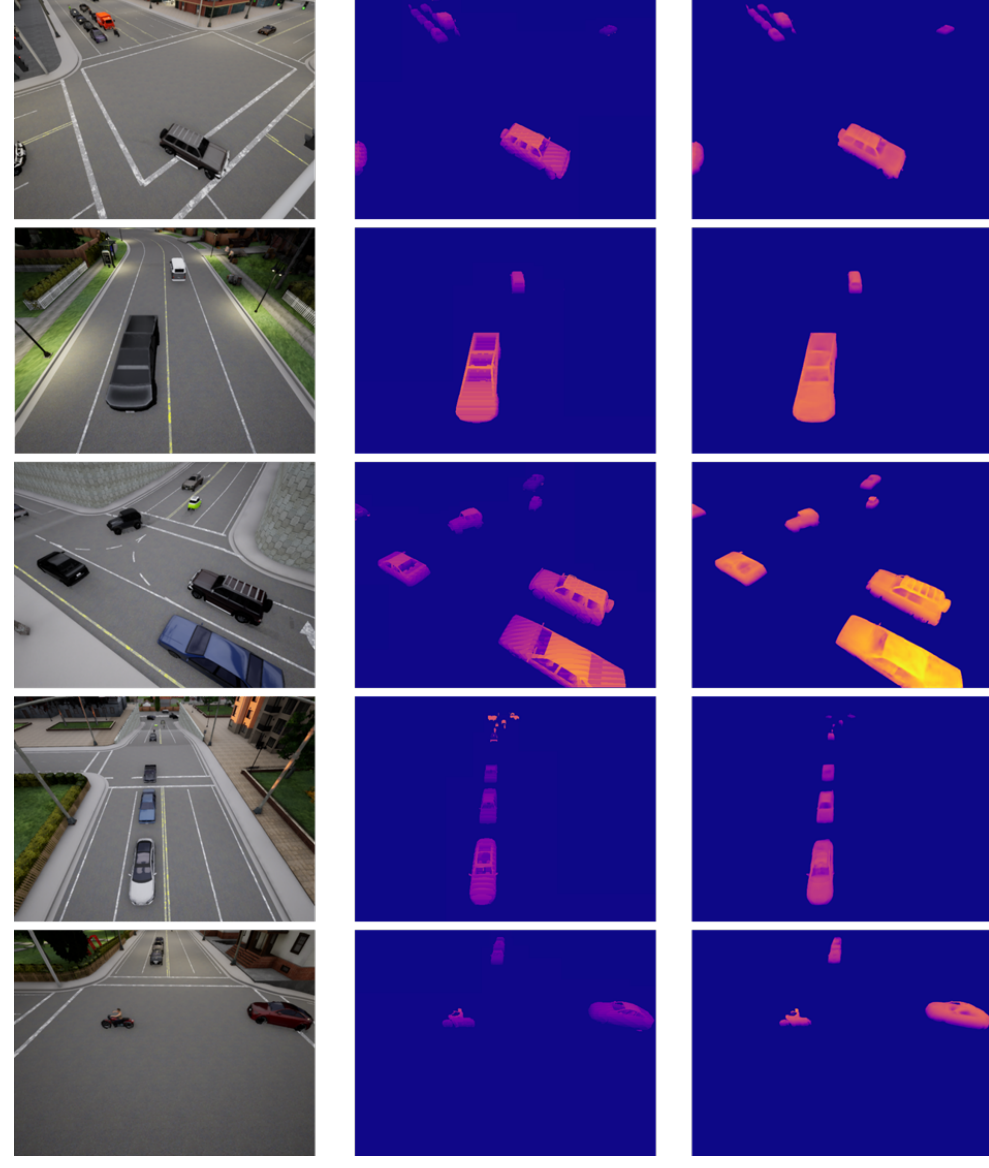
Figure 4. Experimental Results of Height Estimation Network. Original image ( Left ), Ground Truth ( Middle ), Estimated height ( Right